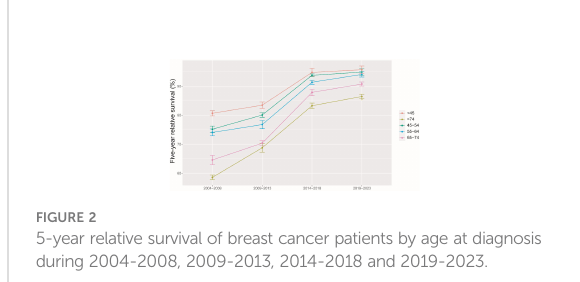
FIGURE 2 5-year relative survival of breast cancer patients by age at diagnosis during 2004-2008, 2009-2013, 2014-2018 and